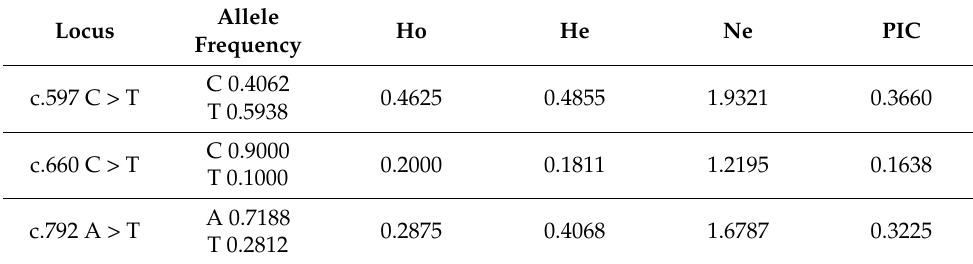
Table 3. Polymorphic parameters of SNP loci of the Mm-Smad3 gene. Allele Ho He Ne PIC Locus Frequency